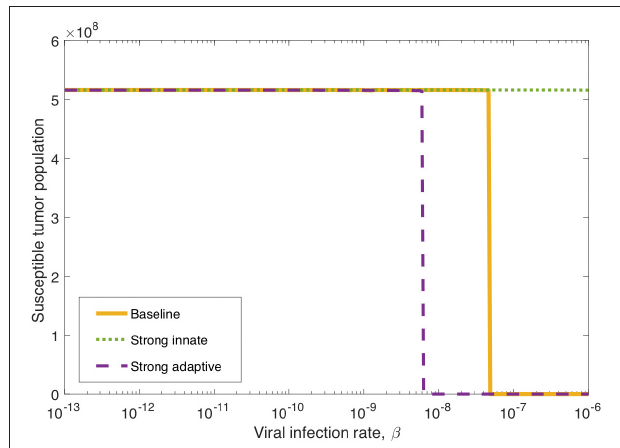
FIGURE 6 | Long-term tumor size, after 3,000 h, as the viral infection rate, β varies. The tumors were treated with a single oncolytic viral dose, and we compare between a baseline tumor and a tumor with strong innate or a strong adaptive immune system. In the strong innate case, k VZ = 2 and s ZR = 0.2. In the strong adaptive case, a AT = 0.05.